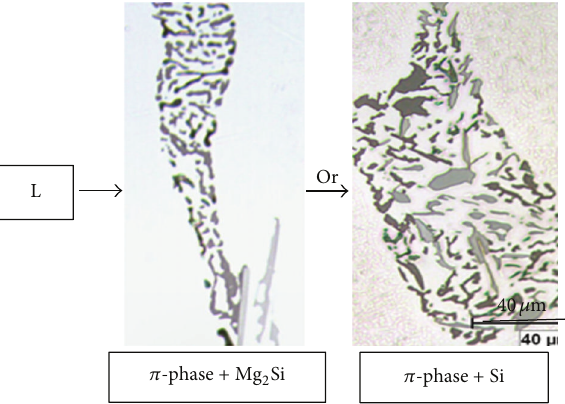
Figure 7: Optical microstructures of Be-containing C3B alloy showing the new eutectic-like reaction sequence.